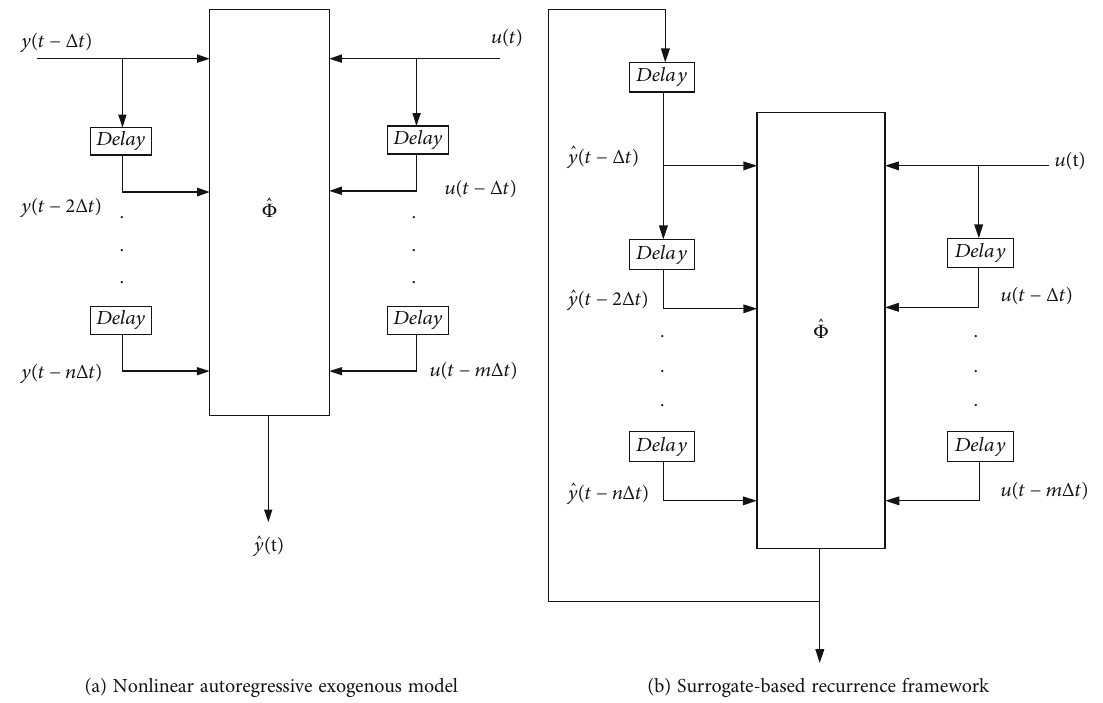
Figure 3: The recurrence scheme for time-series prediction of ROM.